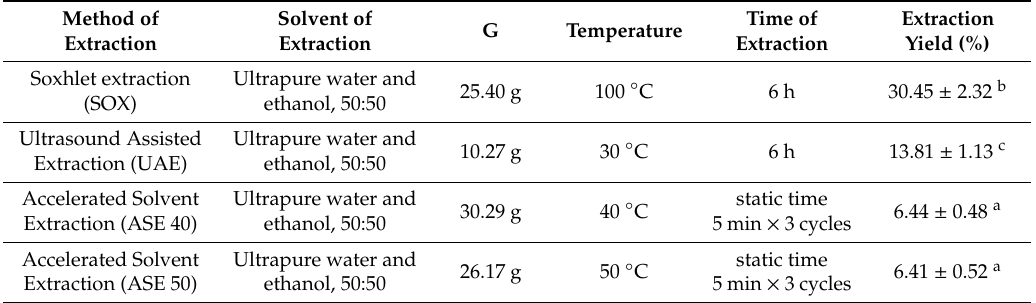
Table 1. Extraction parameters to recovery the bioactive compounds from grape leaves of Vitis vinifera L. (cv.